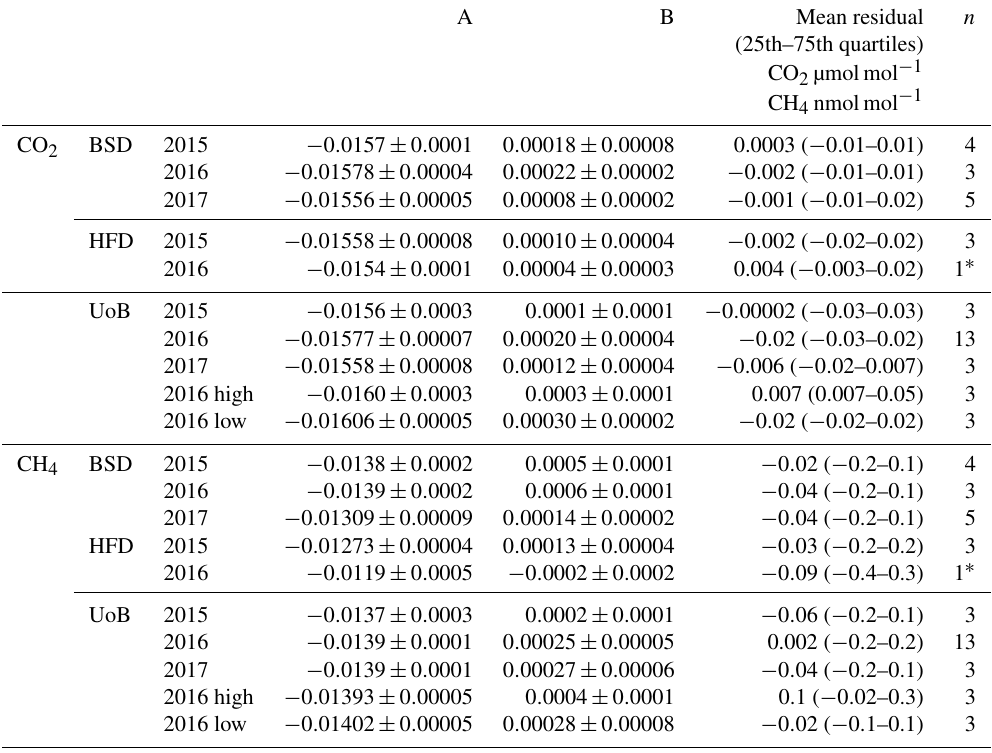
Table 1. Instrument-specific water corrections for the Bilsdale (BSD), Heathfield (HFD) and University of Bristol (UoB) CRDS instruments. The parameters shown are the mean ± the 95% confidence interval of tests repeated in triplicate. Water corrections labelled high and low were determined using an above-ambient and below-ambient mole fraction cylinder respectively, while the rest were determined using an ambient mole fraction cylinder. The mean residual along with the interquartile range of the residuals are included. A B Mean residual